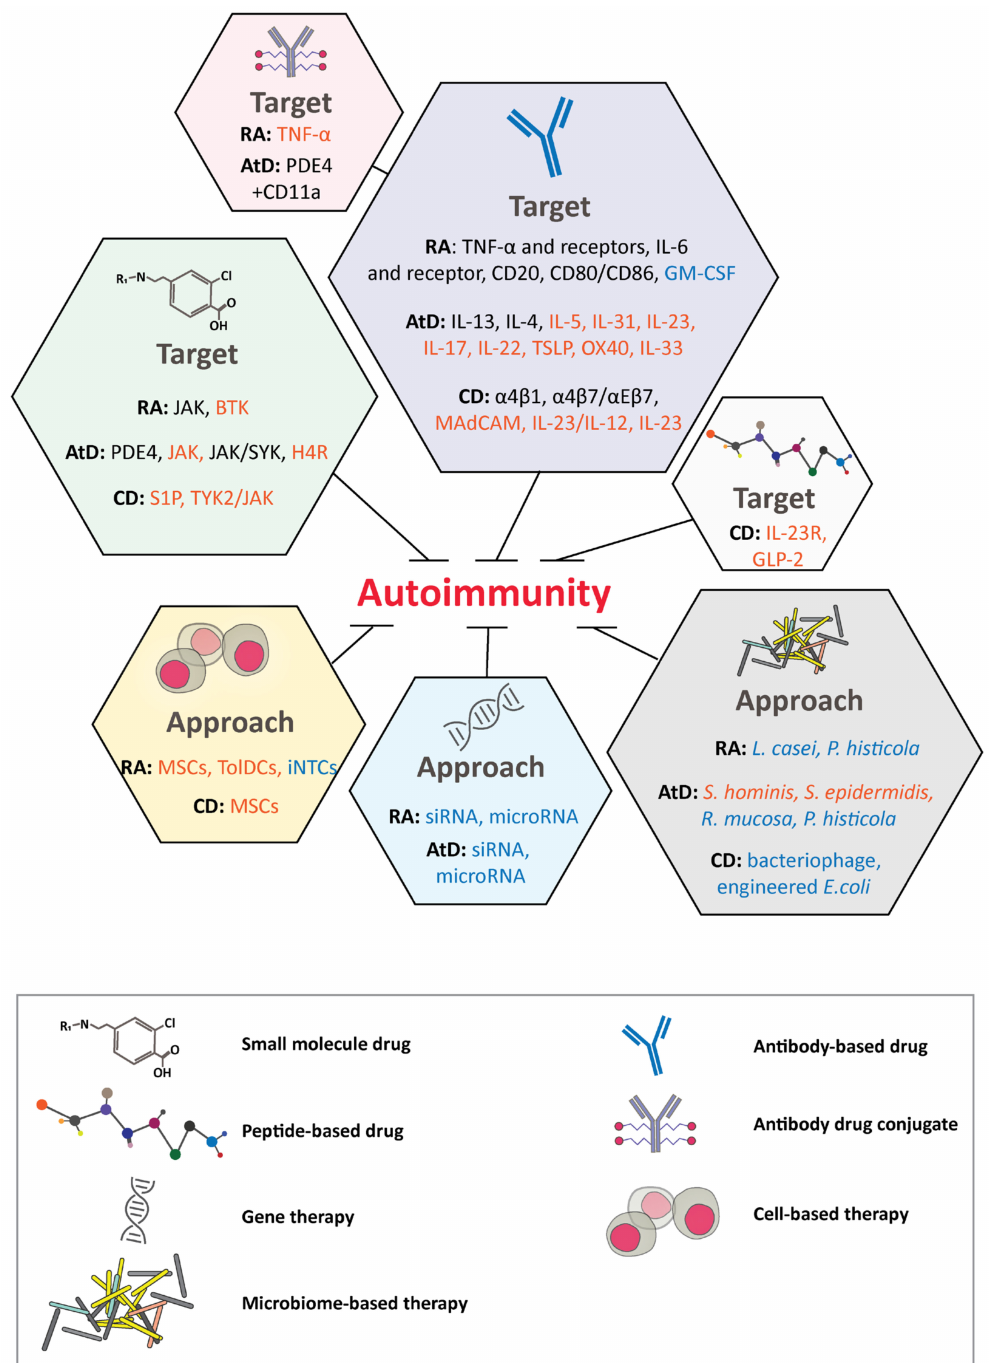
Figure 2. Therapeutic targets and modalities discussed here to inhibit autoimmunity in rheumatoid arthritis, atopic dermatitis, and Crohn’s disease. Targets shown in back represent corresponding drugs in the market. Targets and approaches in shown orange and blue represent corresponding drugs in clinical and clinical development, respectively. RA: Rheumatoid arthritis; AtD: Atopic dermatitis; CD: Crohn’s disease; TNF: Tumor necrosis factor; PDE4: Phosphodiesterase 4; JAK: Janus kinase; BTK: Bruton’s tyrosine kinase; SYK: Spleen tyrosine kinase; H4R: Histamine H4 receptor; S1P: Sphingosine 1-phosphate; TYK2: Tyrosine kinase 2; GM-CSF: Granulocyte-macrophage colony stimulating factor; TSLP: Thymic stromal lymphopoietin; MAdCAM: Mucosal addressin cell adhesion molecule; GLP-2: Glucagon-like peptide 2; MSCs: Mesenchymal stem cells; TolDCs: Tolerogenic dendritic cells; INTCs: Invariant natural killer T cells; siRNA: Short interfering